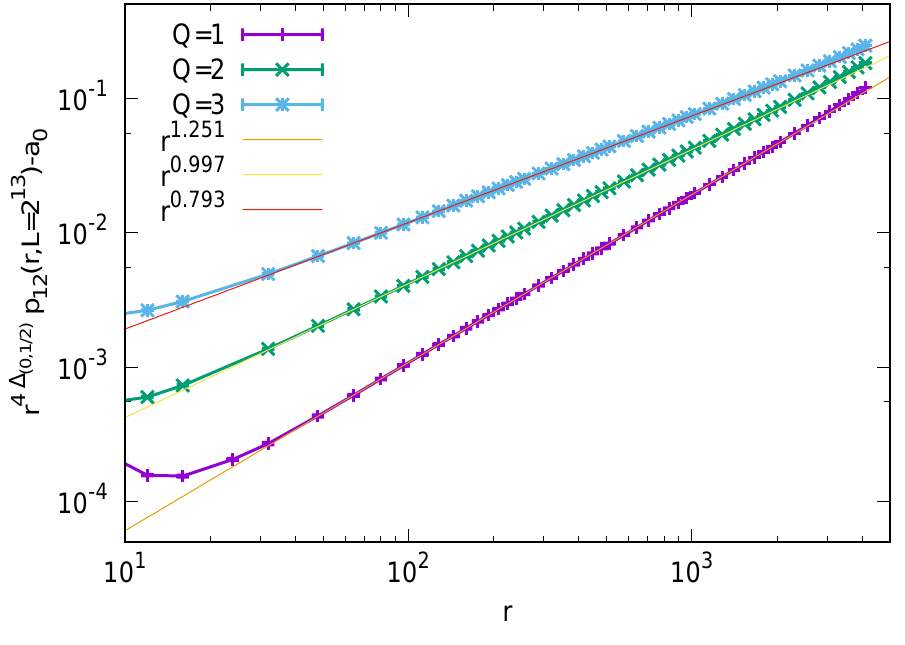
4 ∆ ( 0,1 ( r , L = 2 13 ) (cid:0) a ) p as a function of r in the 2 12 0